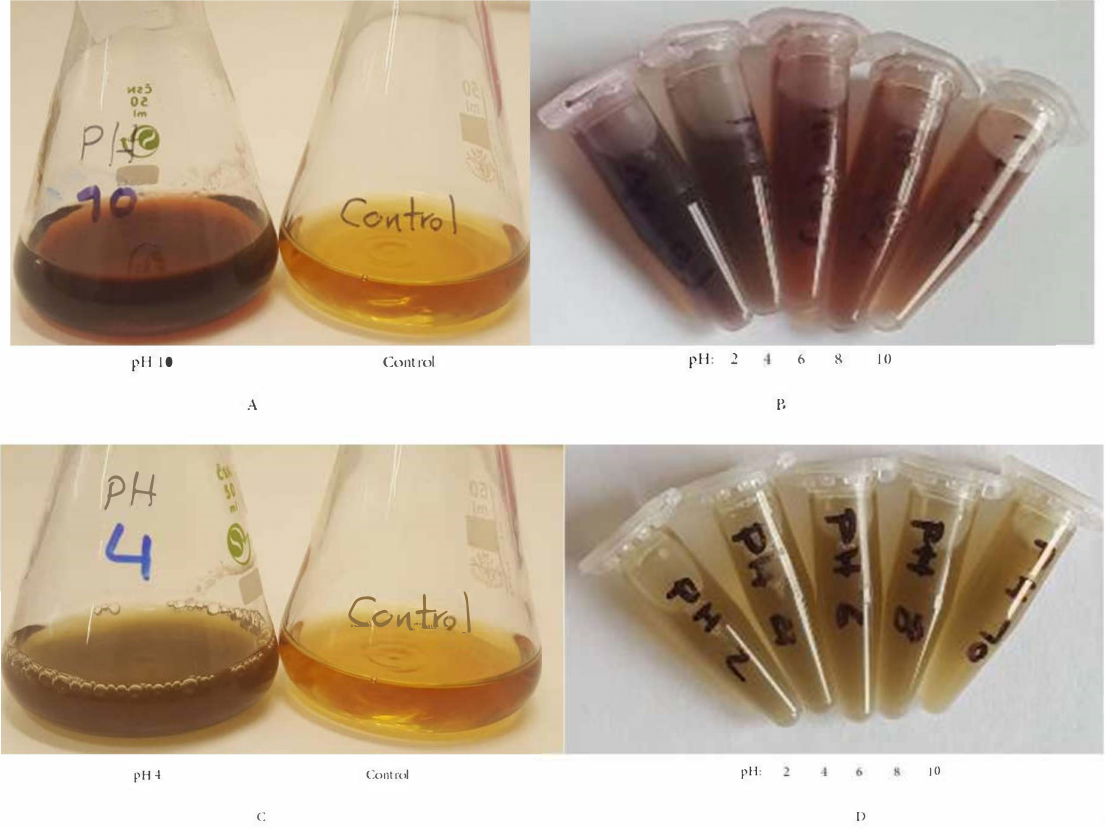
Figure 8. pH adjustment after AuNP preparation. Two samples with acidic and alkaline pH were used (pH 4 and 10): ( A ) initial color of the sample at pH 10 in contrast to control; ( B ) color-changed AuNPs after second pH adjustment; ( C ) initial color of the sample at pH 4 in contrast to control; ( D ) color-changed AuNPs after the second pH